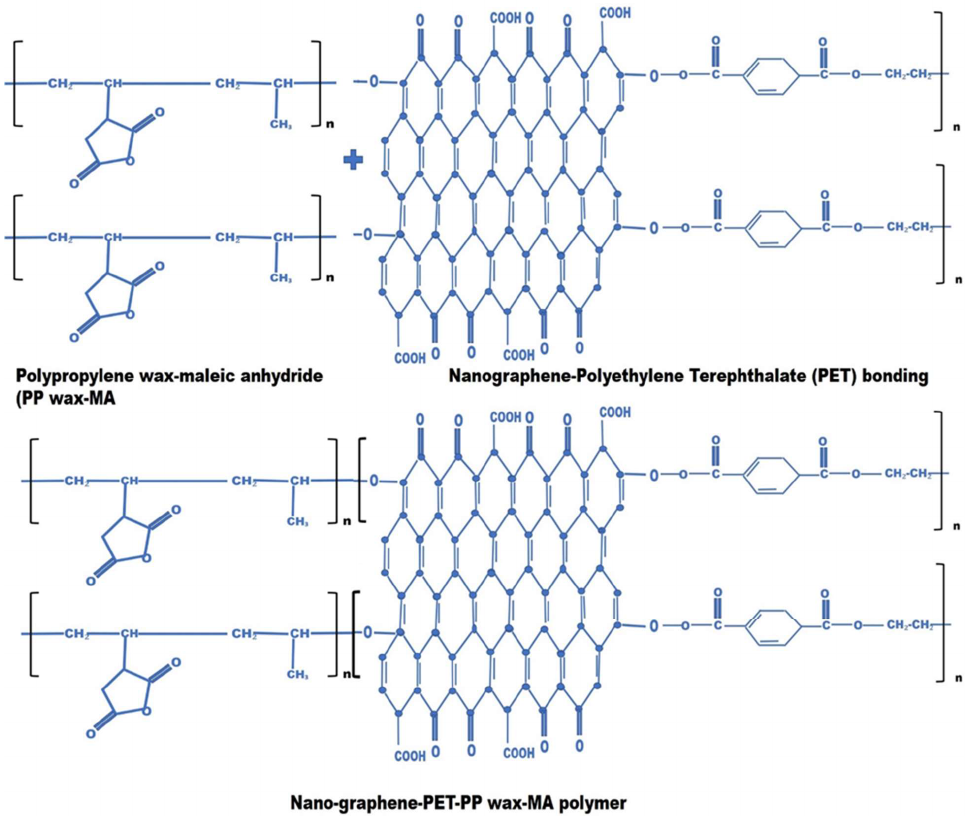
Figure 3. Ternary composite of nanographene-polyethylene terephthalate-polypropylene polymer.